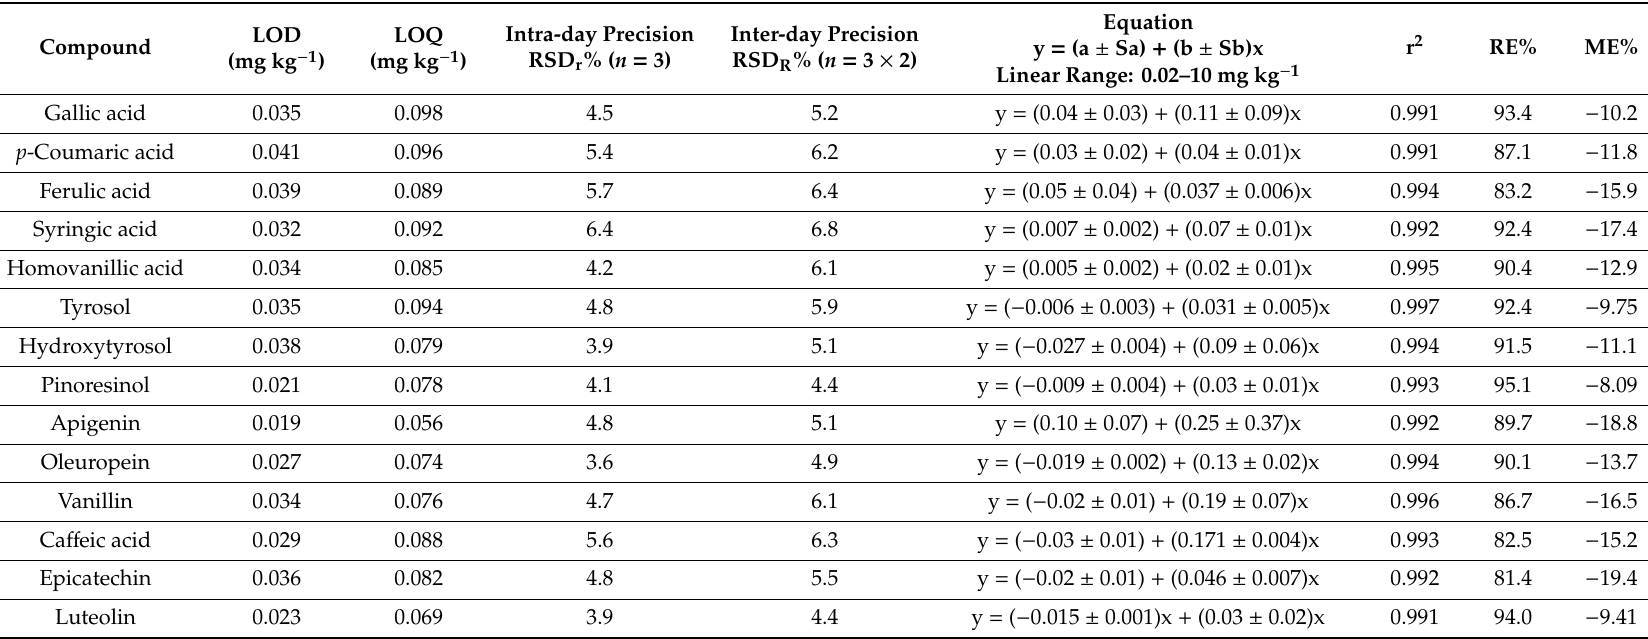
Table 1. Reversed phase ultra-high-pressure liquid chromatography quadrupole time-of-flight mass spectrometric (RP-UHPLC-ESI-QTOF-MS / MS) method performance